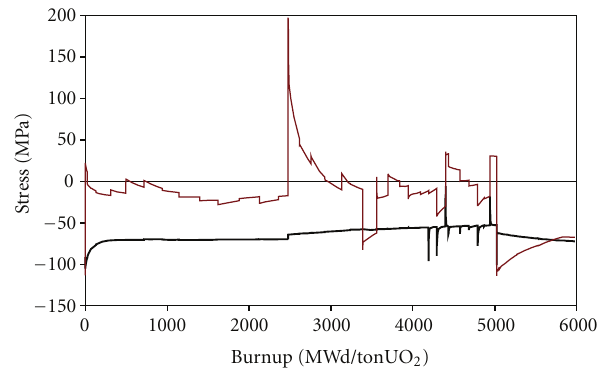
Figure 5: “Hoop stress” at the cladding in the middle of an Atucha I fuel rod with natural UO 2 . Standard (thick line) and minimum gap situation (thin line).